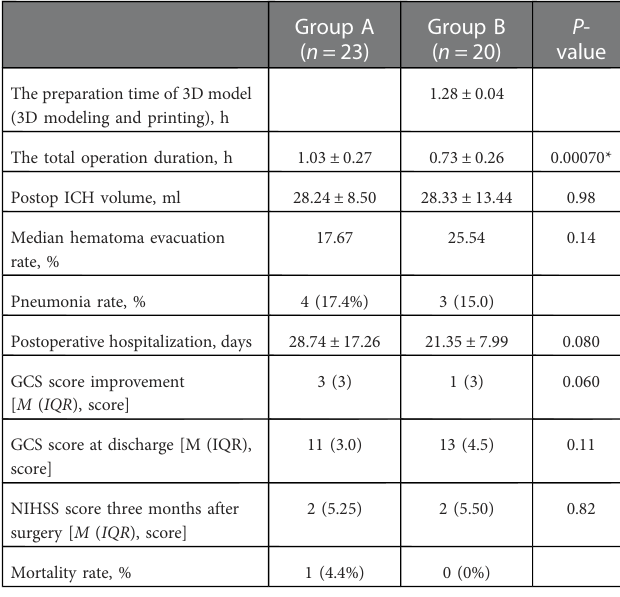
TABLE 2 Operative result of 43 patients with